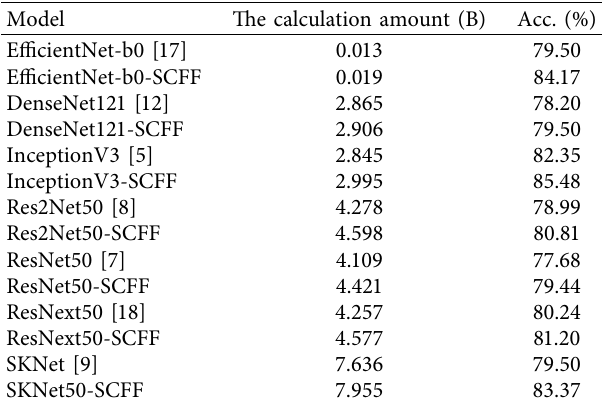
Table 4: The experimental results of 101_ObjectCategories